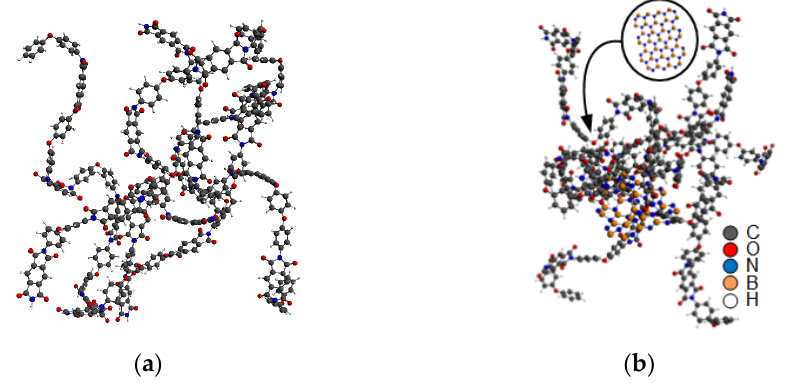
Figure 2. Optimized decomposition model of PI and PI/BNNS. ( a ) PI neat; ( b ) PI/BNNS.